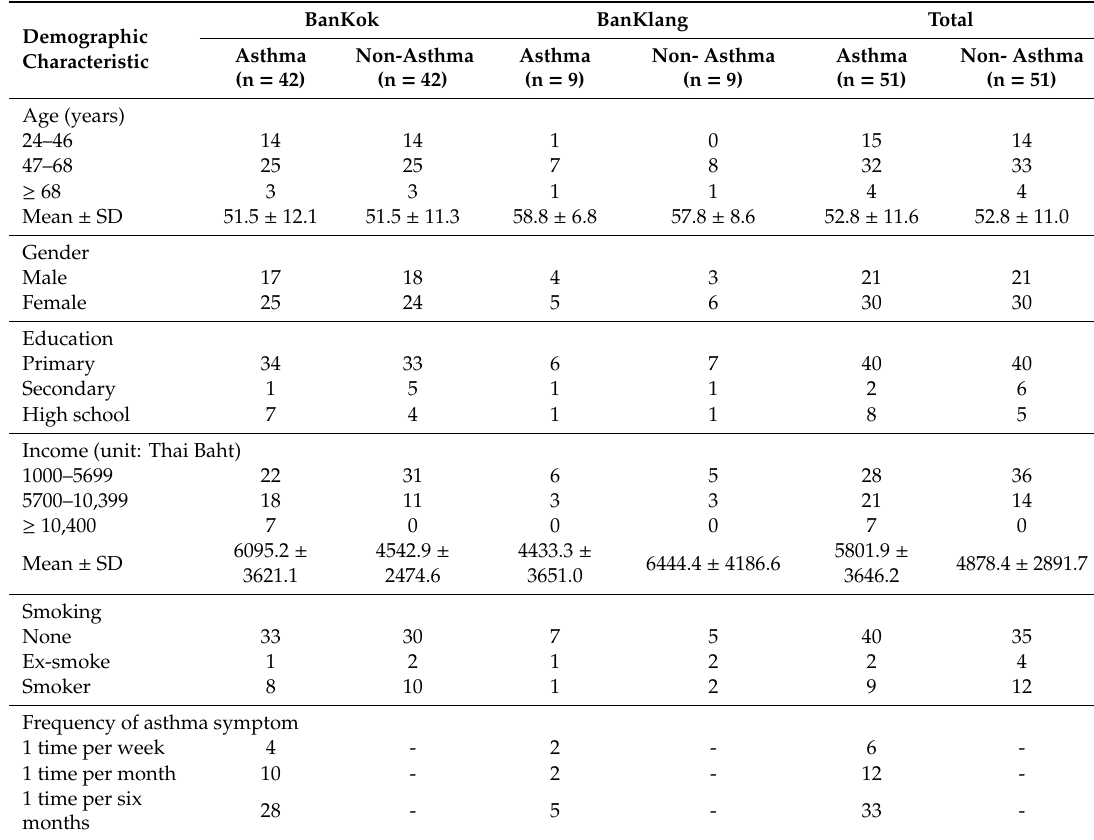
Table 1. Demographic information of participants stratified by site and